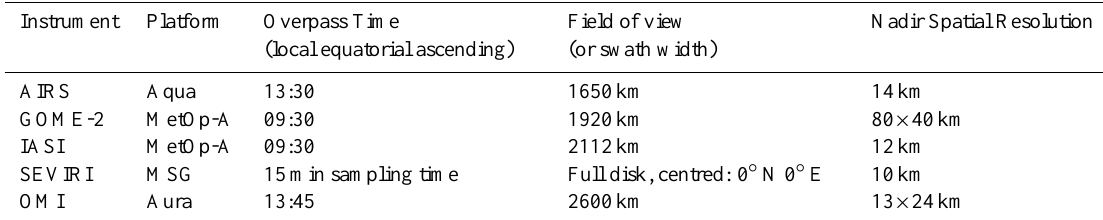
Table 1. Properties of the instruments used in this study. Instrument Platform Overpass Time Field of view Nadir Spatial Resolution (local equatorial ascending) (or swath width) AIRS Aqua 13:30 1650km 14km GOME-2 MetOp-A 09:30 1920km 80 × 40km IASI MetOp-A 09:30 2112km 12km SEVIRI MSG 15min sampling time Full disk, centred: 0 ◦ N 0 ◦ E 10km OMI Aura 13:45